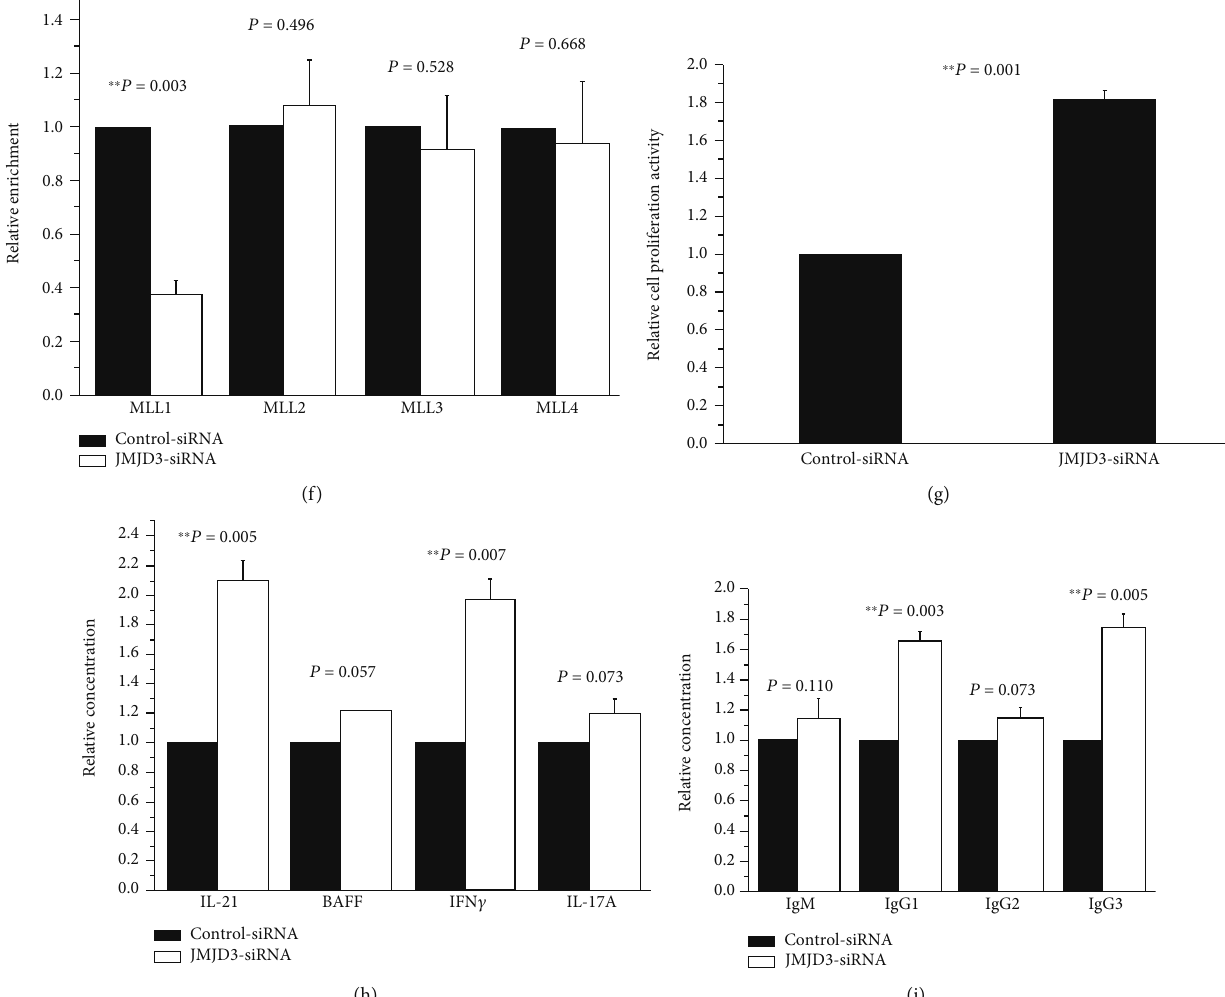
Figure 3: E ff ects of JMJD3 downregulation on Tfh cells from 3 normal controls. (a, b) Relative JMJD3 and HPK1 protein levels in normal Tfh cells transfected with control-siRNA or JMJD3-siRNA were measured by western blot analysis after stimulation. β -Actin was used as endogenous control. (c – f) Relative JMJD3 (c), H3K27me3 (d), H3K4me3 (e), MLL1, MLL2, MLL3, and MLL4 (f) enrichments at the HPK1 promoter in normal Tfh cells transfected with control-siRNA or JMJD3-siRNA were quanti fi ed by combining ChIP and qPCR assays after stimulation. Results were normalized to input DNA (total chromatin). (g) The proliferation activities of normal Tfh cells transfected with control-siRNA or JMJD3-siRNA were assessed by MTT assays after stimulation. (h) The relative concentrations of IL- 21, BAFF, IFN γ , and IL-17A in the supernatants of normal Tfh cells transfected with control-siRNA or JMJD3-siRNA were examined using ELISA after stimulation. (i) After stimulation, some normal Tfh cells transfected with control-siRNA or JMJD3-siRNA were cocultured with autologous B cells for 8 days, whereafter the concentrations of IgM, IgG1, IgG2, and IgG3 in the supernatants were detected by ELISA. The data from every control-siRNA group member were set as 1, and the multiple of every JMJD3-siRNA group member relative to its homologous control-siRNA group member was